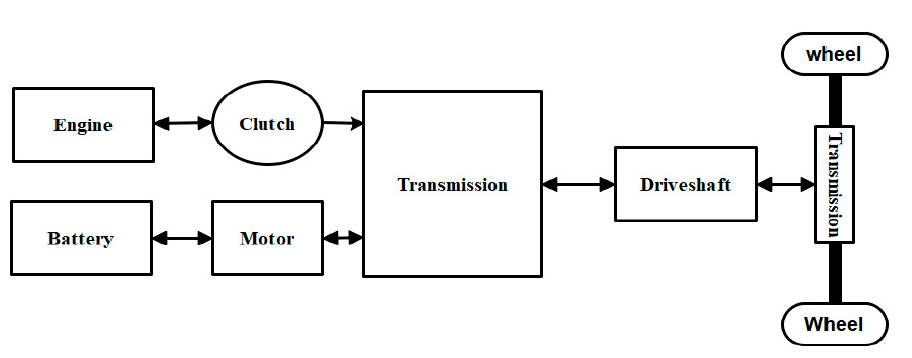
Figure 1. Parallel hybrid electric vehicle (HEV) block diagram.